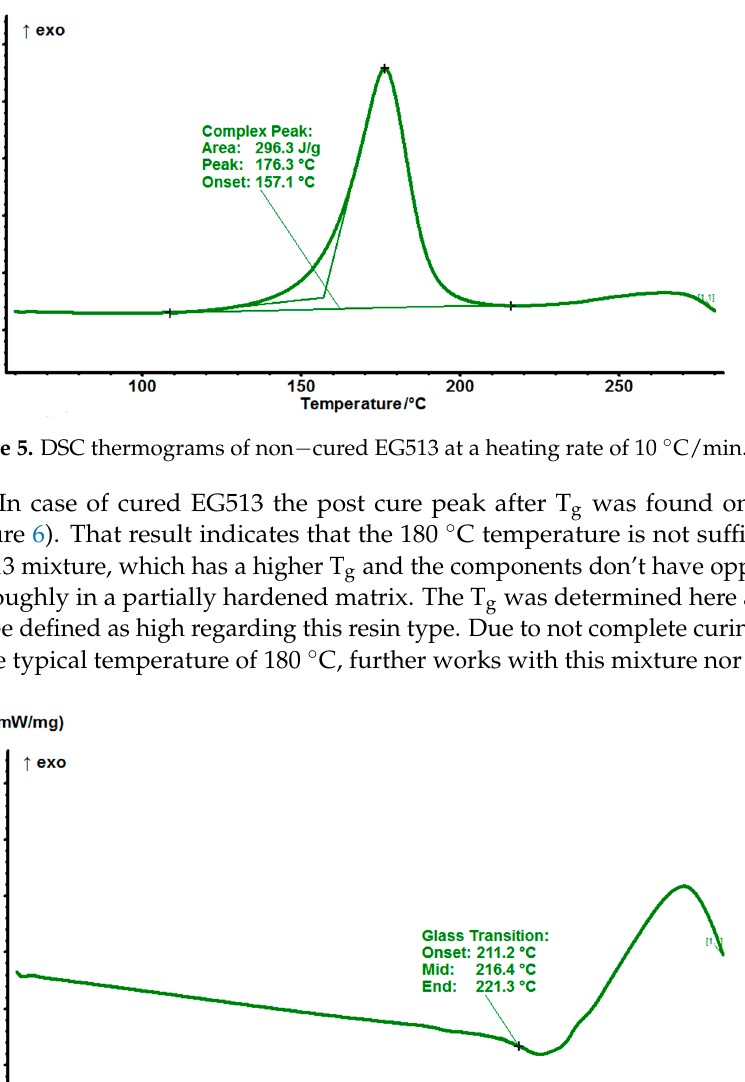
Figure 5. DSC thermograms of non − cured EG513 at a heating rate of 10 °C/min.